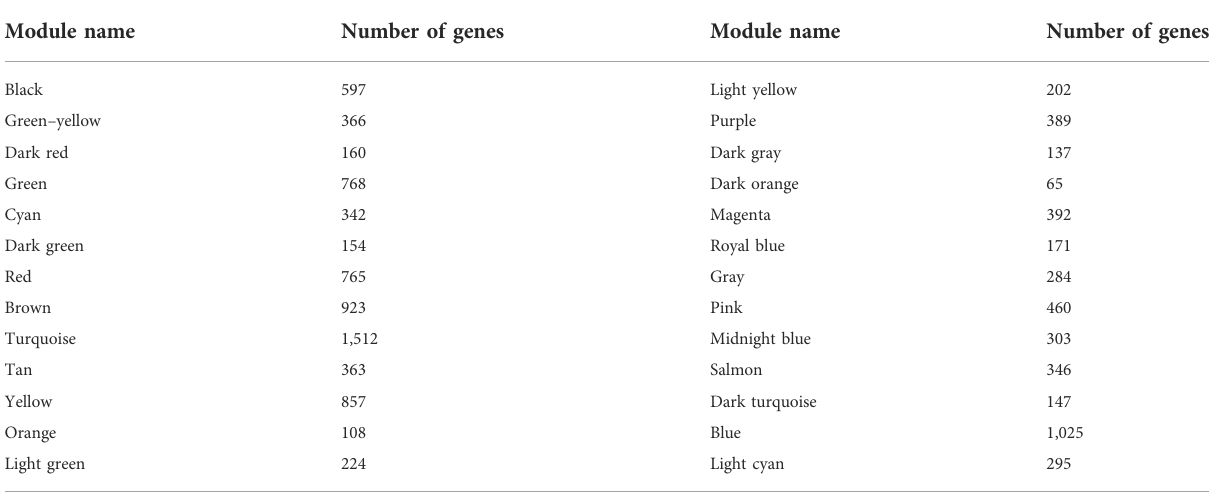
TABLE 1 Gene number information of modules by the